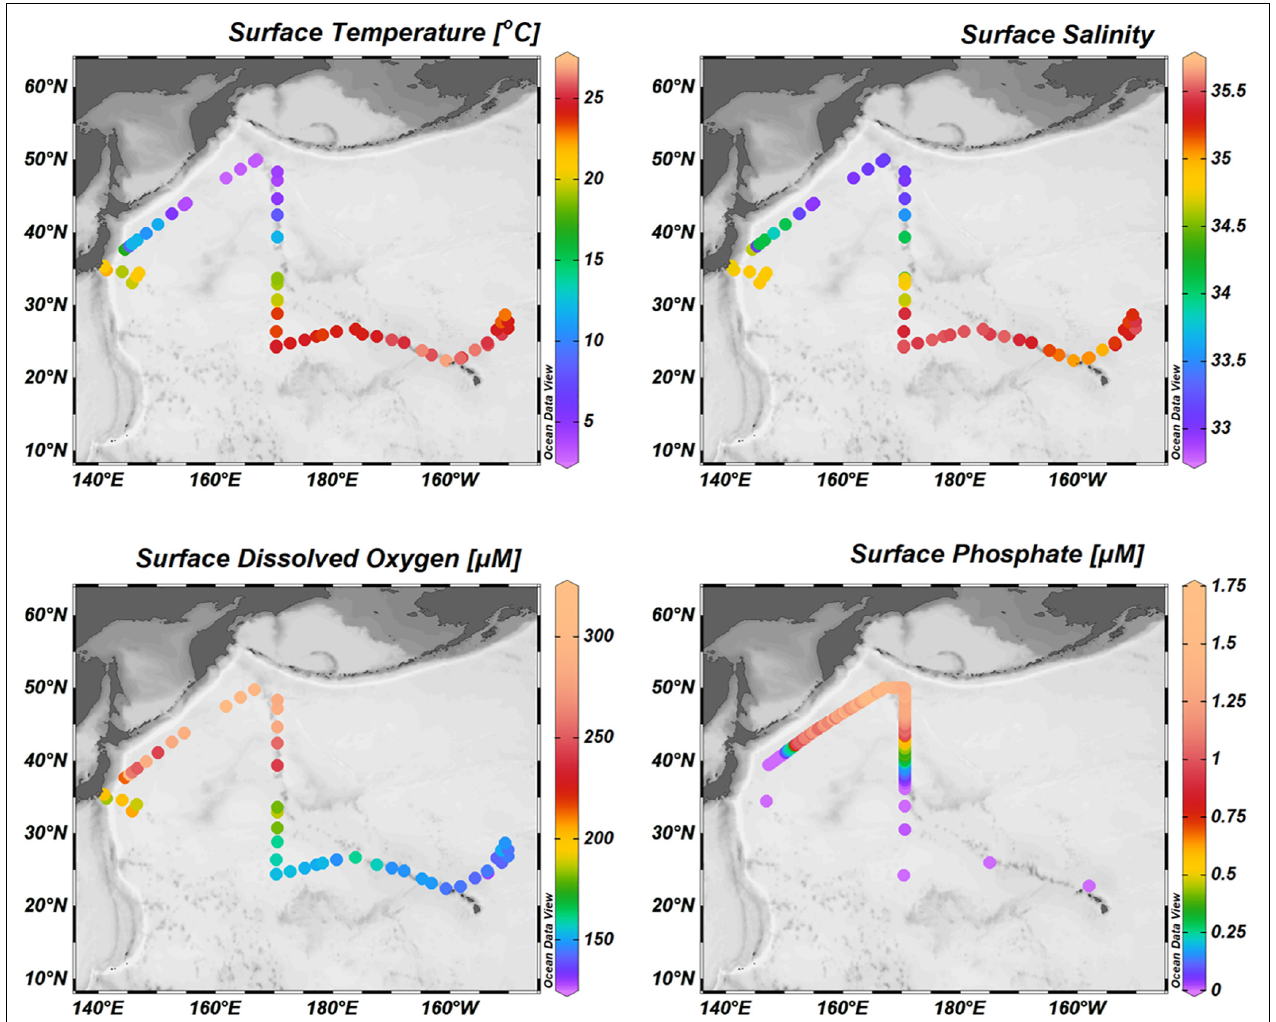
FIGURE 3 | Surface distributions of physical and chemical parameters: the surface distributions of temperature, salinity, dissolved oxygen, and major nutrients like phosphate reflect the physical circulation of the North Pacific Ocean (Measures et al., 2006). The upwelling waters of the western subarctic gyre are characterized by low temperatures and salinities but high concentrations of dissolved oxygen and phosphate. In contrast, the downwelling subtropical gyre is characterized by higher temperatures and salinities but lower concentrations of dissolved oxygen and nearly undetectable concentrations of